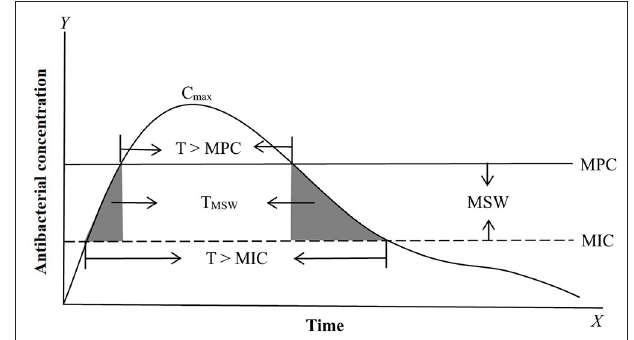
FIGURE 1 | Antimicrobial PK, PD, and PK/PD parameters based on MIC (minimum inhibitory concentration) and MPC (mutant prevention concentration). The most commonly applied PK/PD parameters are AUC/MIC (area under the curve of antibacterial concentration divide MIC) or AUC/MPC, C max /MIC (maximum drug concentration divide MIC) or C max /MPC, and T > MIC (the time of the drug concentration above MIC during the dosage interval) or T > MPC (the time of the drug concentration above MPC during the dosage interval). MSW (mutant selection window) is the drug concentration